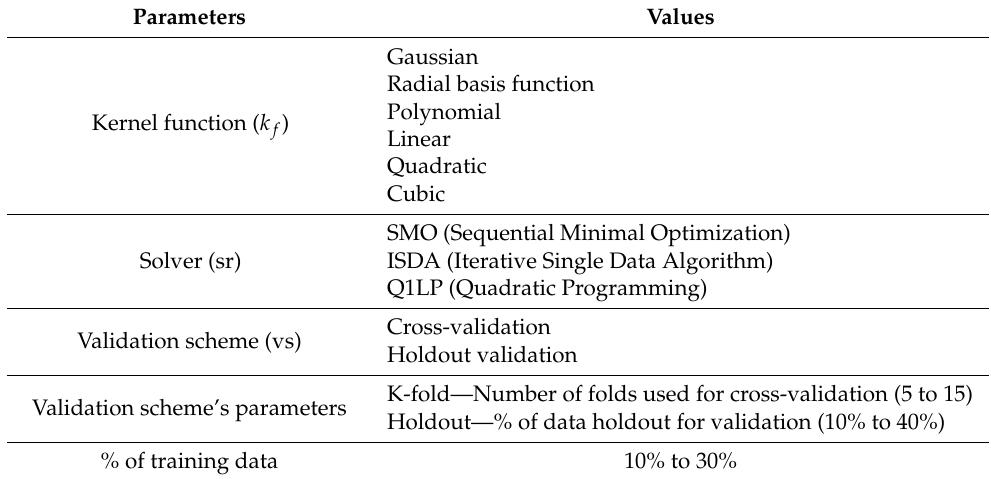
Table 1. List of parameters considered in